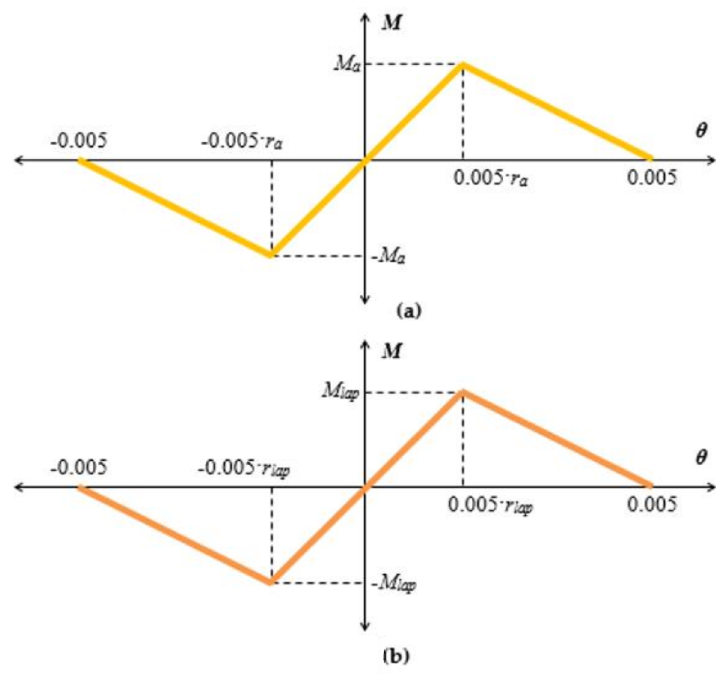
Figure 4. Moment–Rotation ( M - θ ) relationship for simulating ( a ) anchorage and ( b ) lap-splice behavior of longitudinal reinforcement in substandard R/C